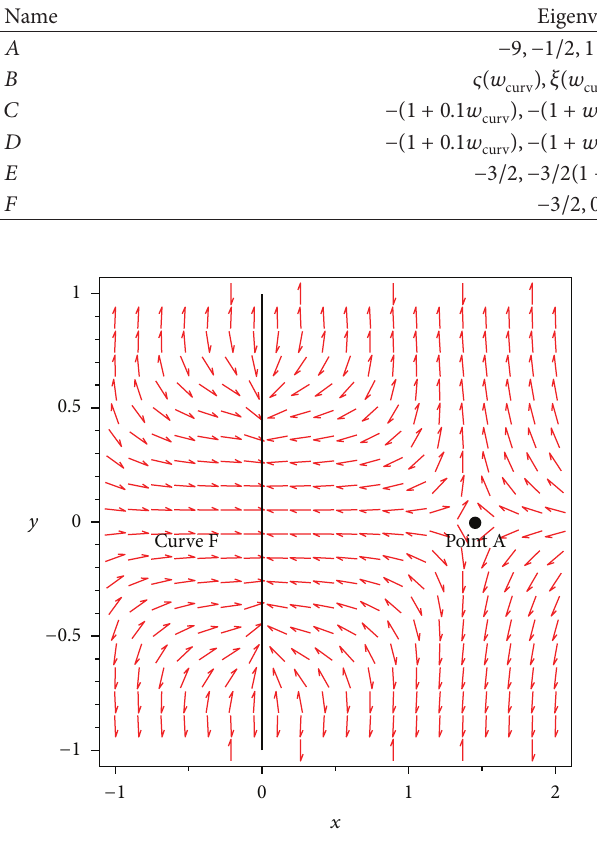
Table 2: Eigenvalues and the stability regions of the critical points. 𝜍(𝑤 critical curve 𝐹 for which 𝑤